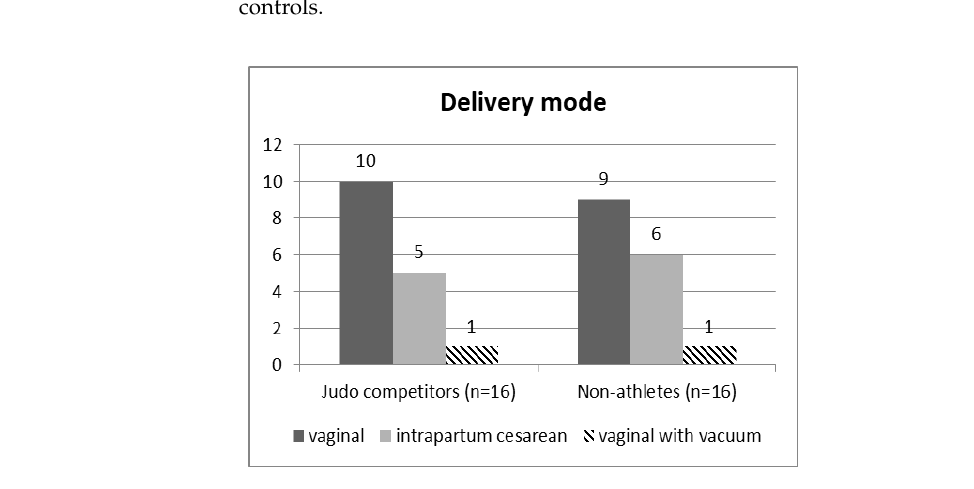
Figure 1. The numbers of first labor ( a ) induction [χ 2 with Yates correction (1) = 0, p = 1], and ( b ) augmentation [χ 2 with Yates correction (1) = 0.05, p = 0.82] in elite judo athletes and non-athlete controls.